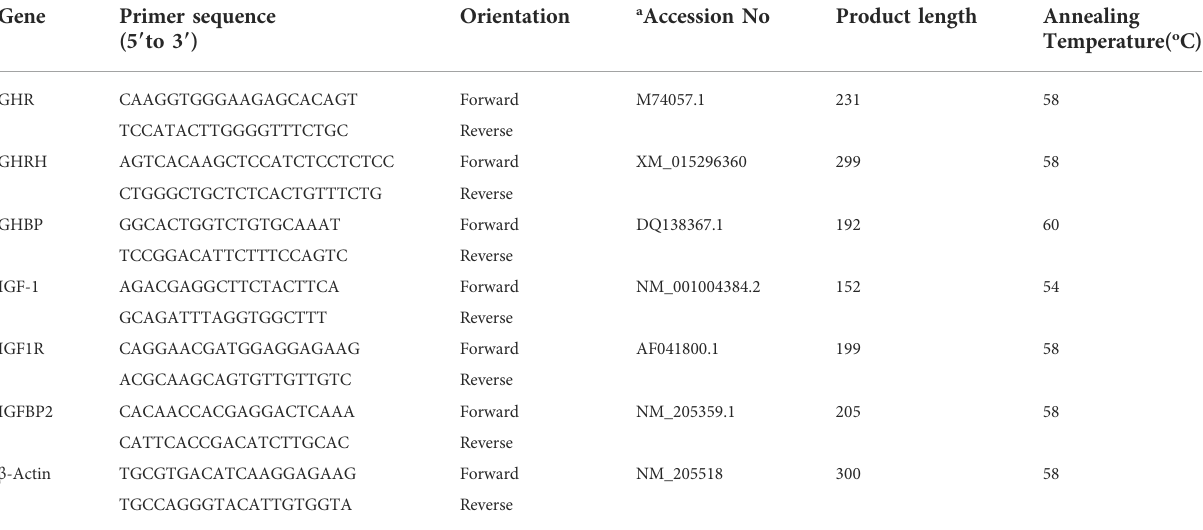
TABLE 2 List of primers used for real-time PCR